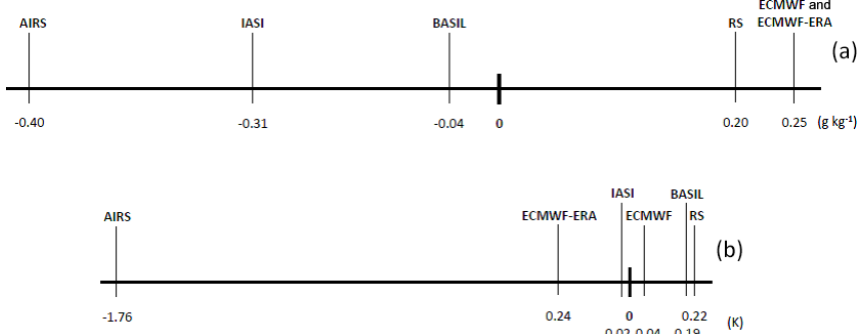
Figure 8. Overall bias affecting the water vapour profile (a) and temperature (b) data.